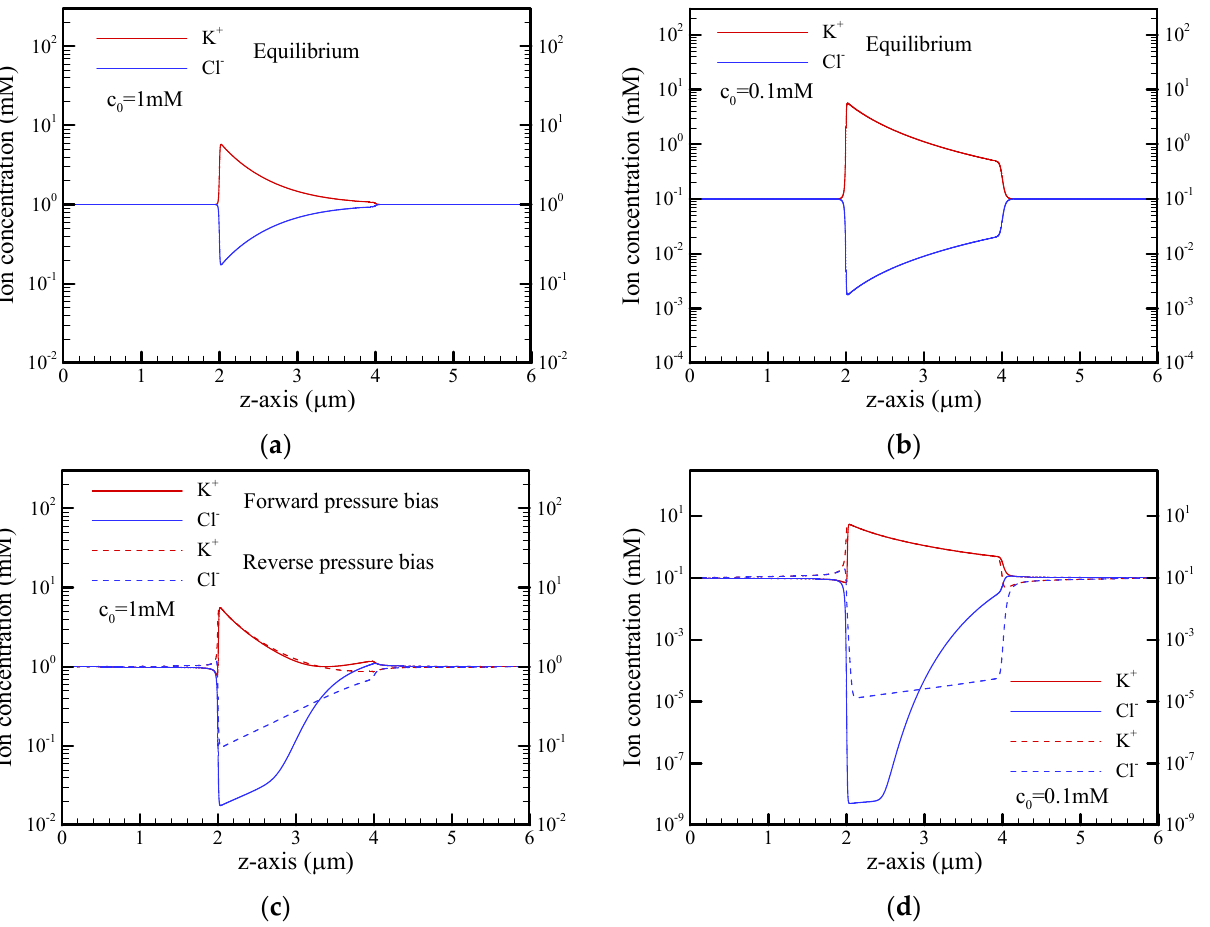
Figure 5. Plots of the cation (K + ) and anion (Cl − ) concentrations along the centerline of the reservoir and conical nanopore for salt concentrations of c 0 = 1 mM and c 0 = 0.1 mM under the short-circuit condition and different pressure biases. ( a , b ) p ext = 0 kPa (equilibrium state); ( c , d ) p ext = 500 kPa. Note that the solid and dashed lines in ( c , d ) represent the results of forward pressure bias and reverse pressure bias, respectively. Note that θ = 1.2°, σ s = −5 mC/m 2 , and b = 20 nm.